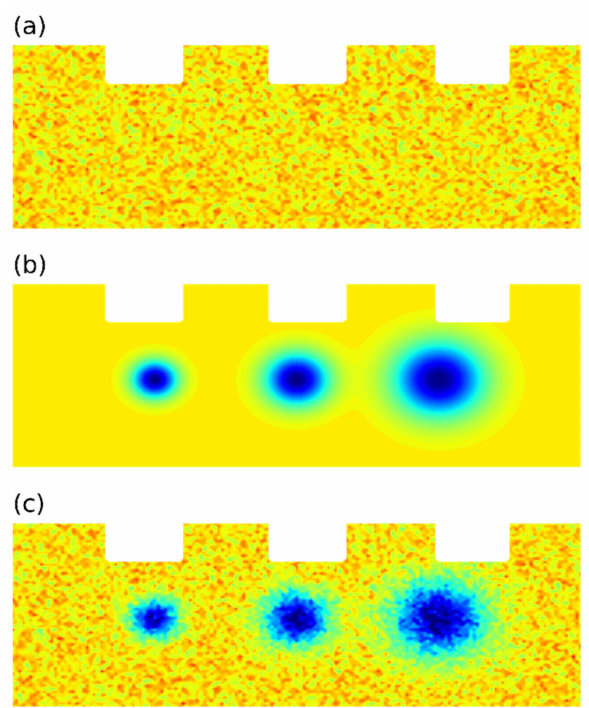
Figure 1. Illustration of toy example generation. Part ( a ) refers to the base layer built from random sampling, ( b ) is the defect layer to be subtracted, and ( c ) is the final toy example resulting from combining ( a , b